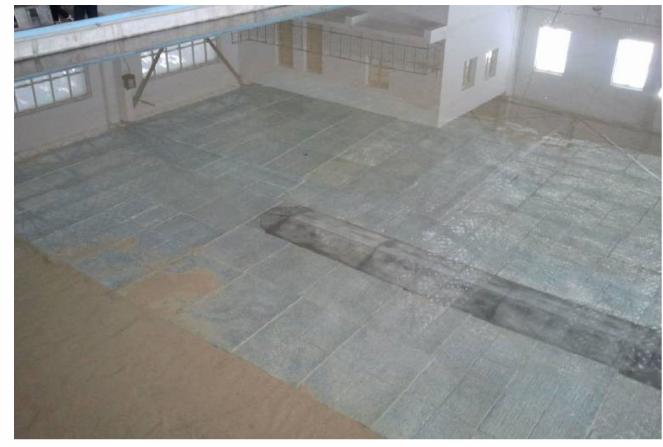
Figure 3. Sketch of model soft mattress.